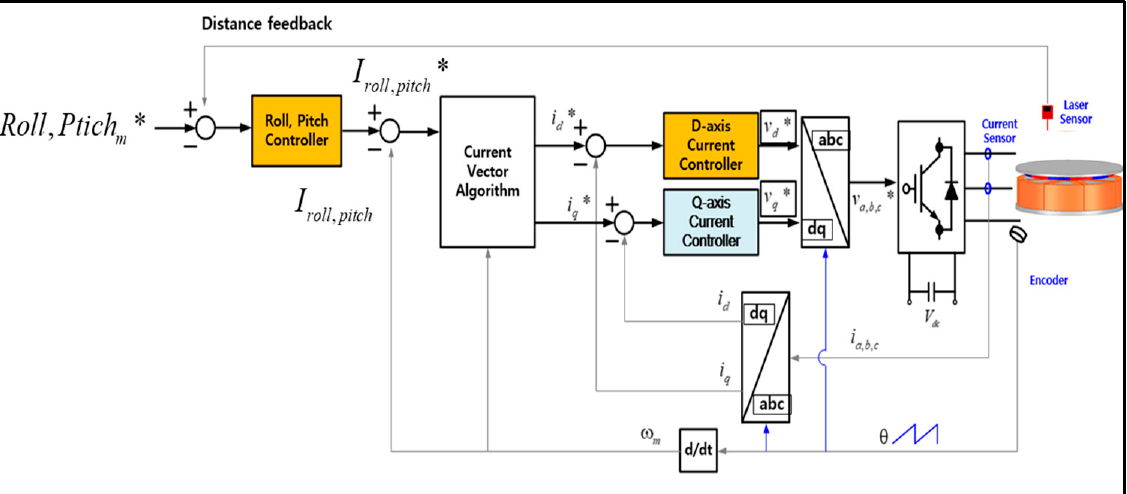
Figure 6. Control block diagram for the tilt (Roll–Pitch) (* is command value).